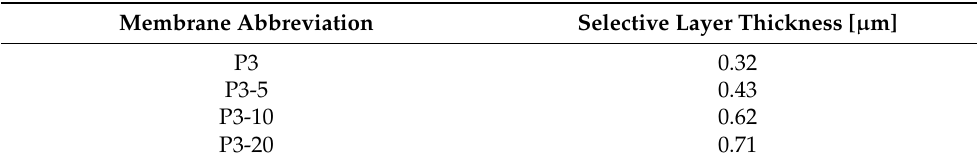
Figure 6. SEM microphotographs of the cross-sections of composite membranes ChS-Fe-BTC/PAN obtained by physical adsorption: ( a ) P3, ( b )P3-5, ( c ) P3-10, ( d ) P3-20. Table 3. Thickness of the selective layer of composite membranes obtained by physical adsorption according to SEM microphotographs.